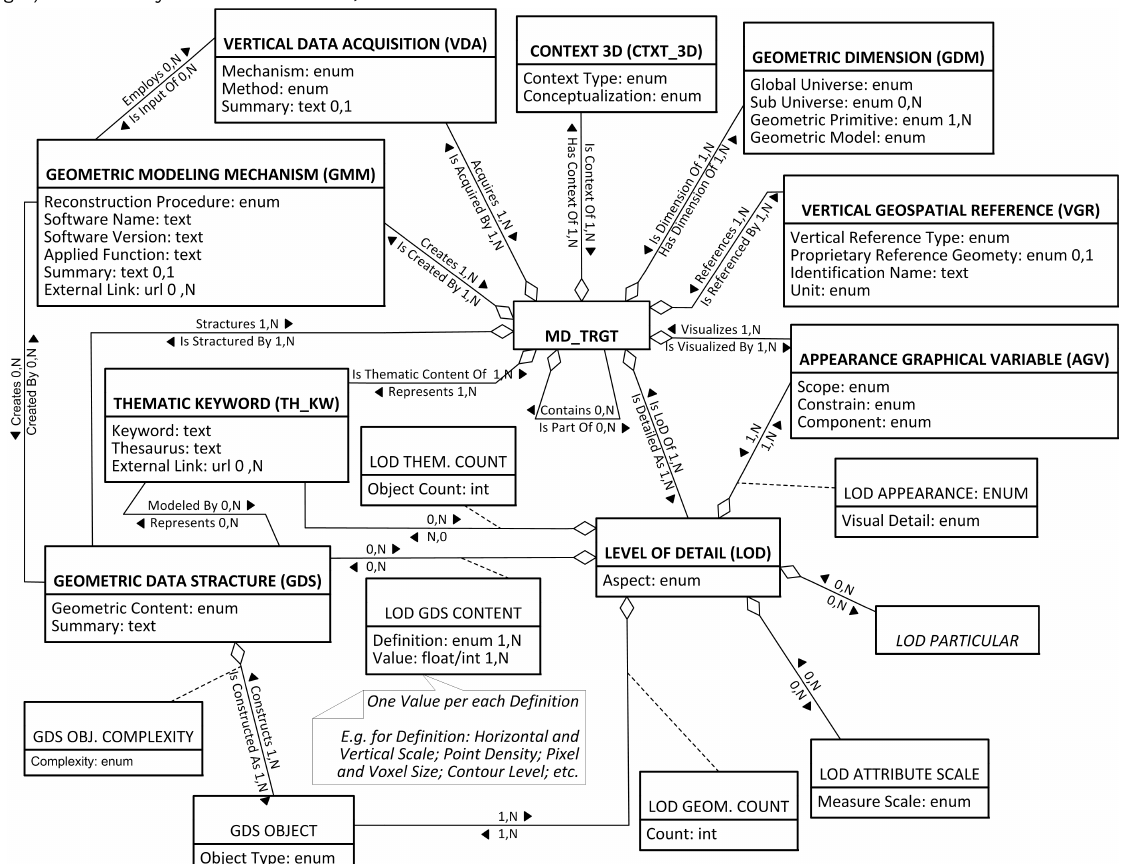
Figure 2. A subset of General package of the proposed metadata-set representing the metadata elements in